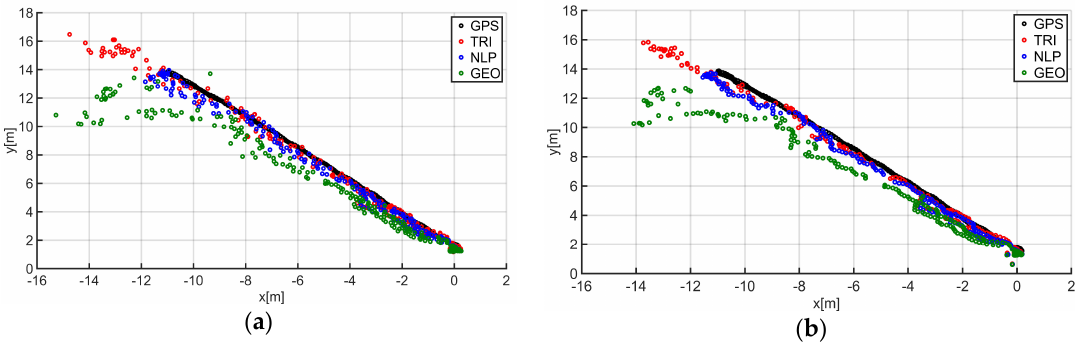
Figure 12. Comparison of the guide location results: ( a ) before final filtering and ( b ) after final filtering.